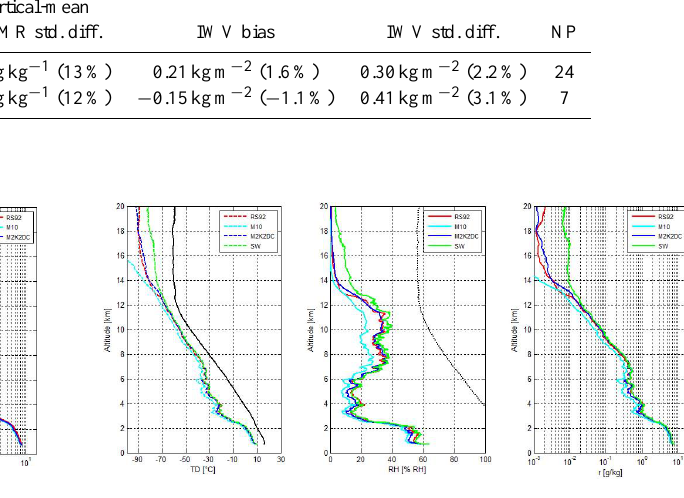
Fig. 9. Similar to Fig. 8, but with measurements from RS92, M10, M2K2DC and SW radiosondes (7